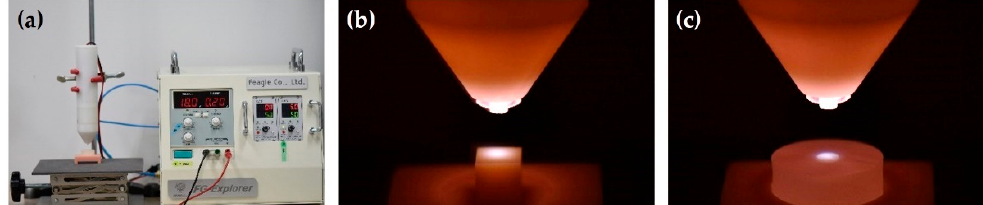
Figure 2. ( a ) Non-thermal atmospheric pressure plasma (NTP) device; ( b ) Plasma treatment on cube-shaped Y-TZP specimen; ( c ) Plasma treatment on disc-shaped Y-TZP specimen embedded in acrylic resin.